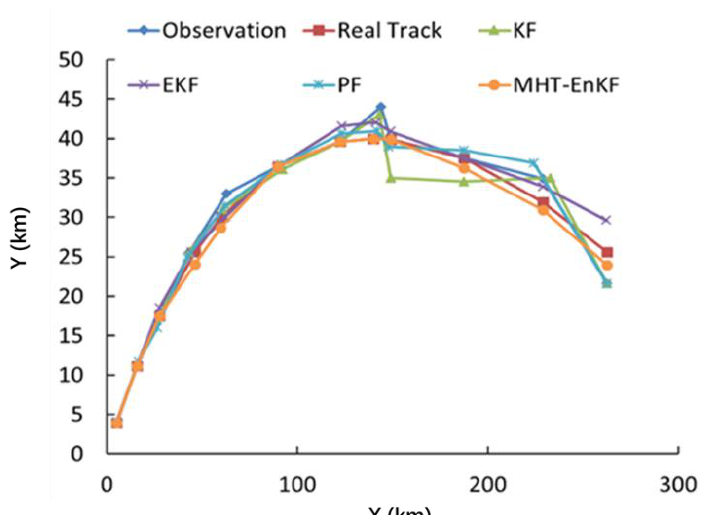
Table 1. The RMSE value of the Kalman filter (KF), extended Kalman filter (EKF), particle filter (PF) and EnKF (units: km).